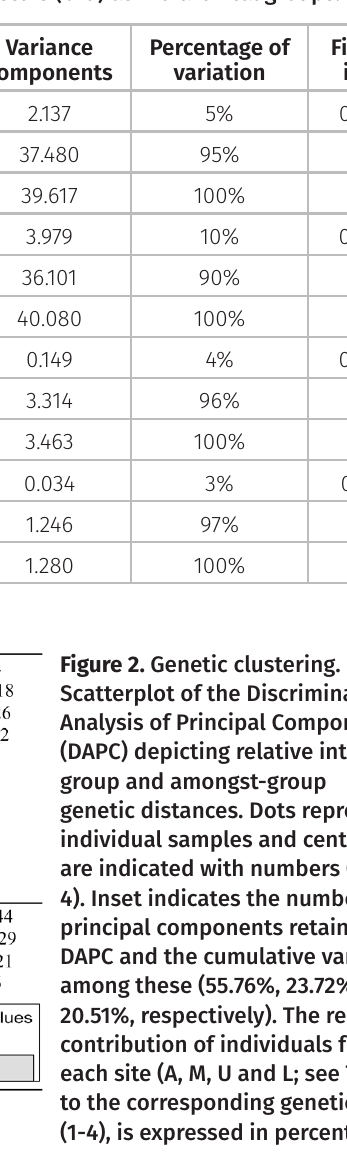
Sum of Variance squares components